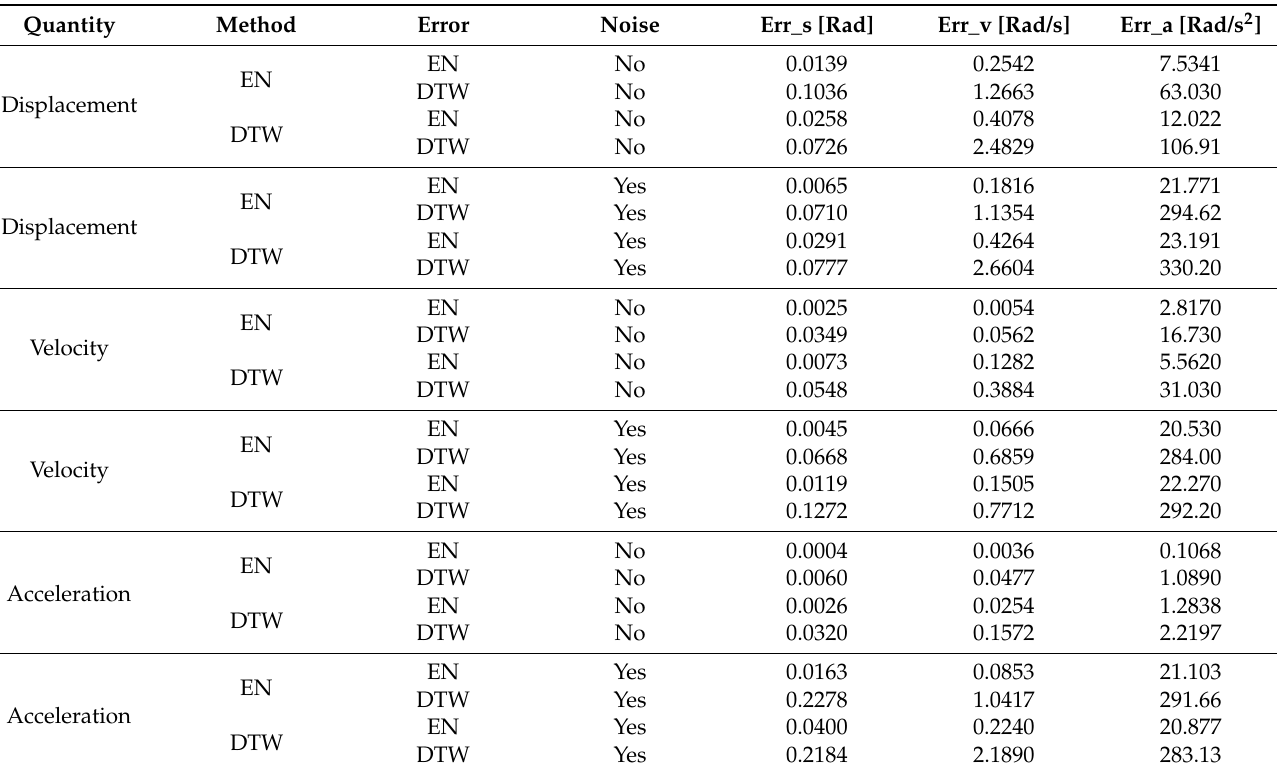
Table 5. Final values of the Euclidean norm and DTW algorithm on displacement, velocity and acceleration, in the simulated cases with law L7 as the original law of motion, with and without noise, and identification based on displacement, velocity and acceleration.